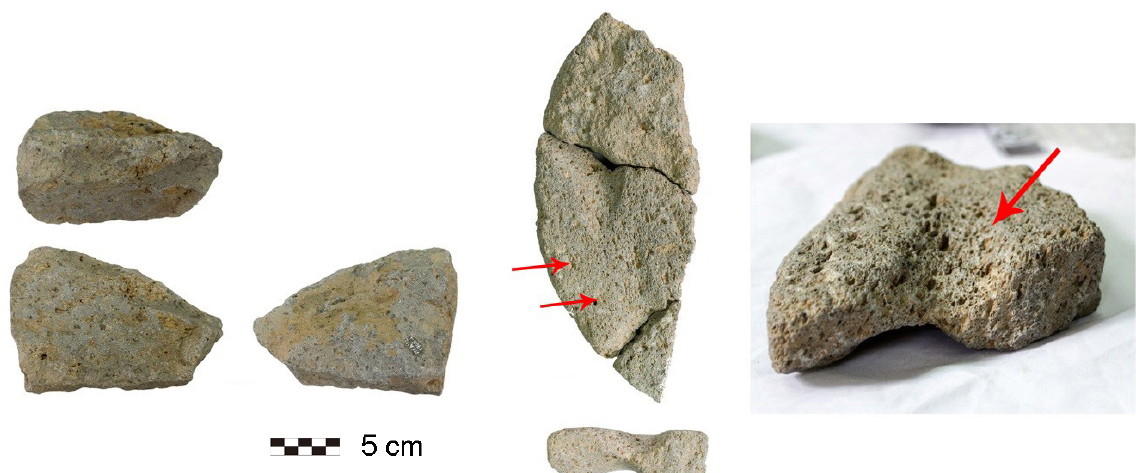
Figure 11. Irregular cobble used as an abrader (left); broken rotary quern fragments with channels indicating they served as abraders (centre); detail of a large channel indicating the rock served to regularise the edges of a rotary quern (right). The scale bar is 5 cm (1 cm